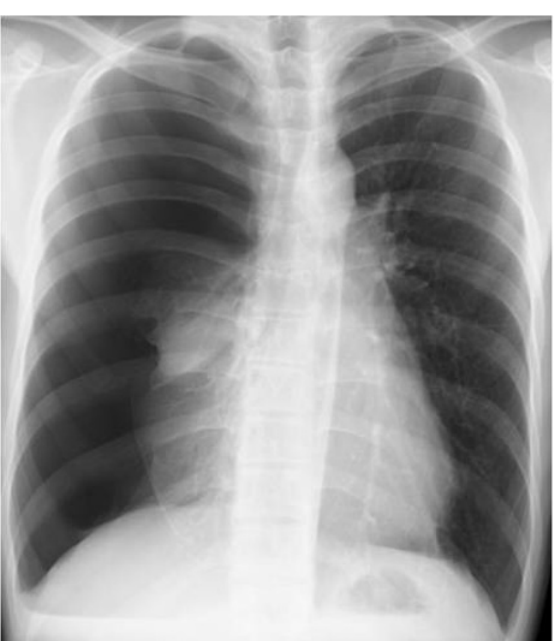
Figure 1. Chest roentgenogram showed right pneumothorax without mediastinal